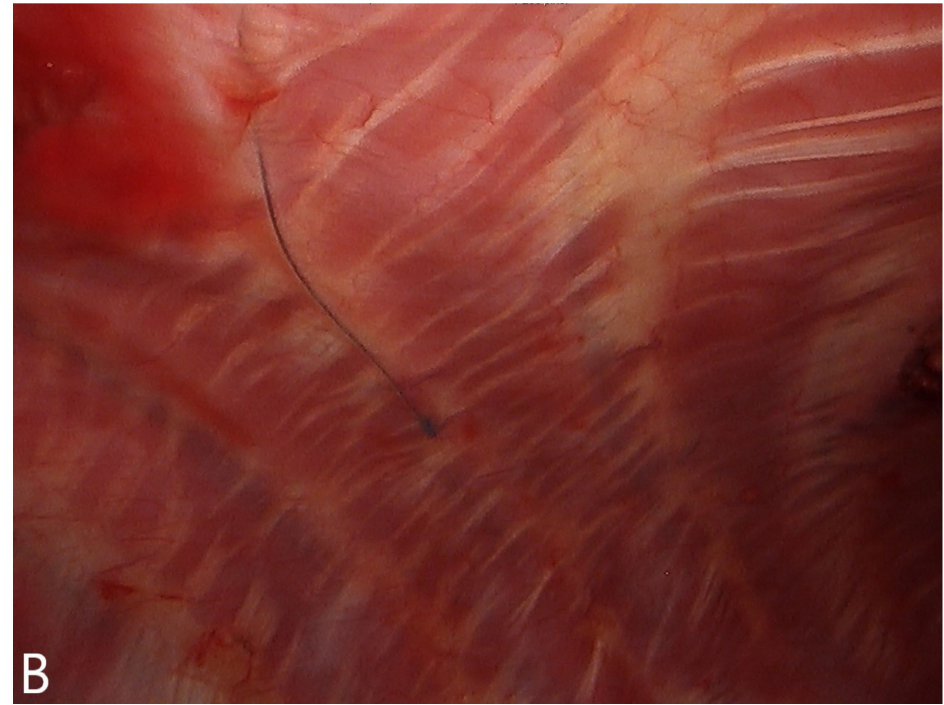
Figure 1. ( A ) View of the intercostal catheter (ICC) after insertion using a 16 Gauge Tuohy needle and a standard peridural catheter. ( B ). Visual control of the ICC. The ICC is placed in the same intercostal space as the chest drain. In the projection of the ICC, the corresponding intercostal nerve and vessels can be